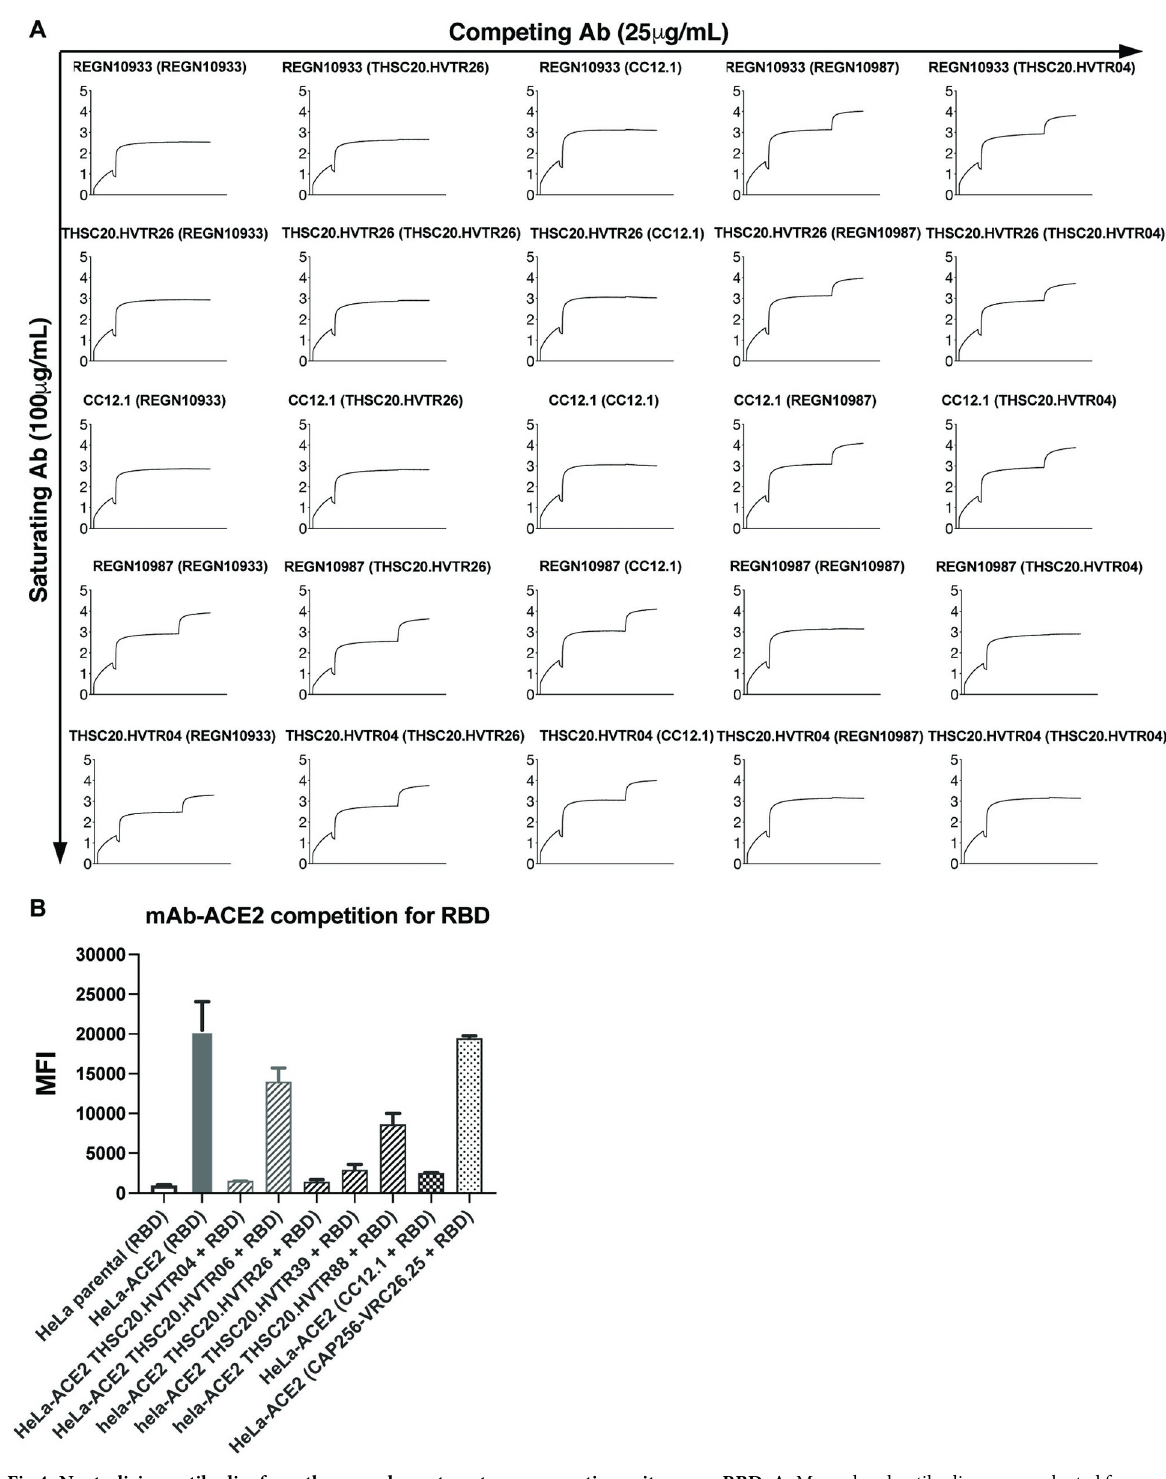
Fig 4. Neutralizing antibodies from the same donor target non-competing epitopes on RBD. A. Monoclonal antibodies were evaluated for epitope competition using BLI. Biotinylated RBD was captured using streptavidin biosensor and indicated mAbs at a concentration of 100 μ g/ml first incubated for 10 min followed by incubation with 25 μ g/ml of competing antibodies for 5 min. B. ACE2-mAb competition for RBD. Inhibition of SARS-CoV-2 RBD binding by five mAbs to the cell surface hACE2 was assessed by flow cytometry.